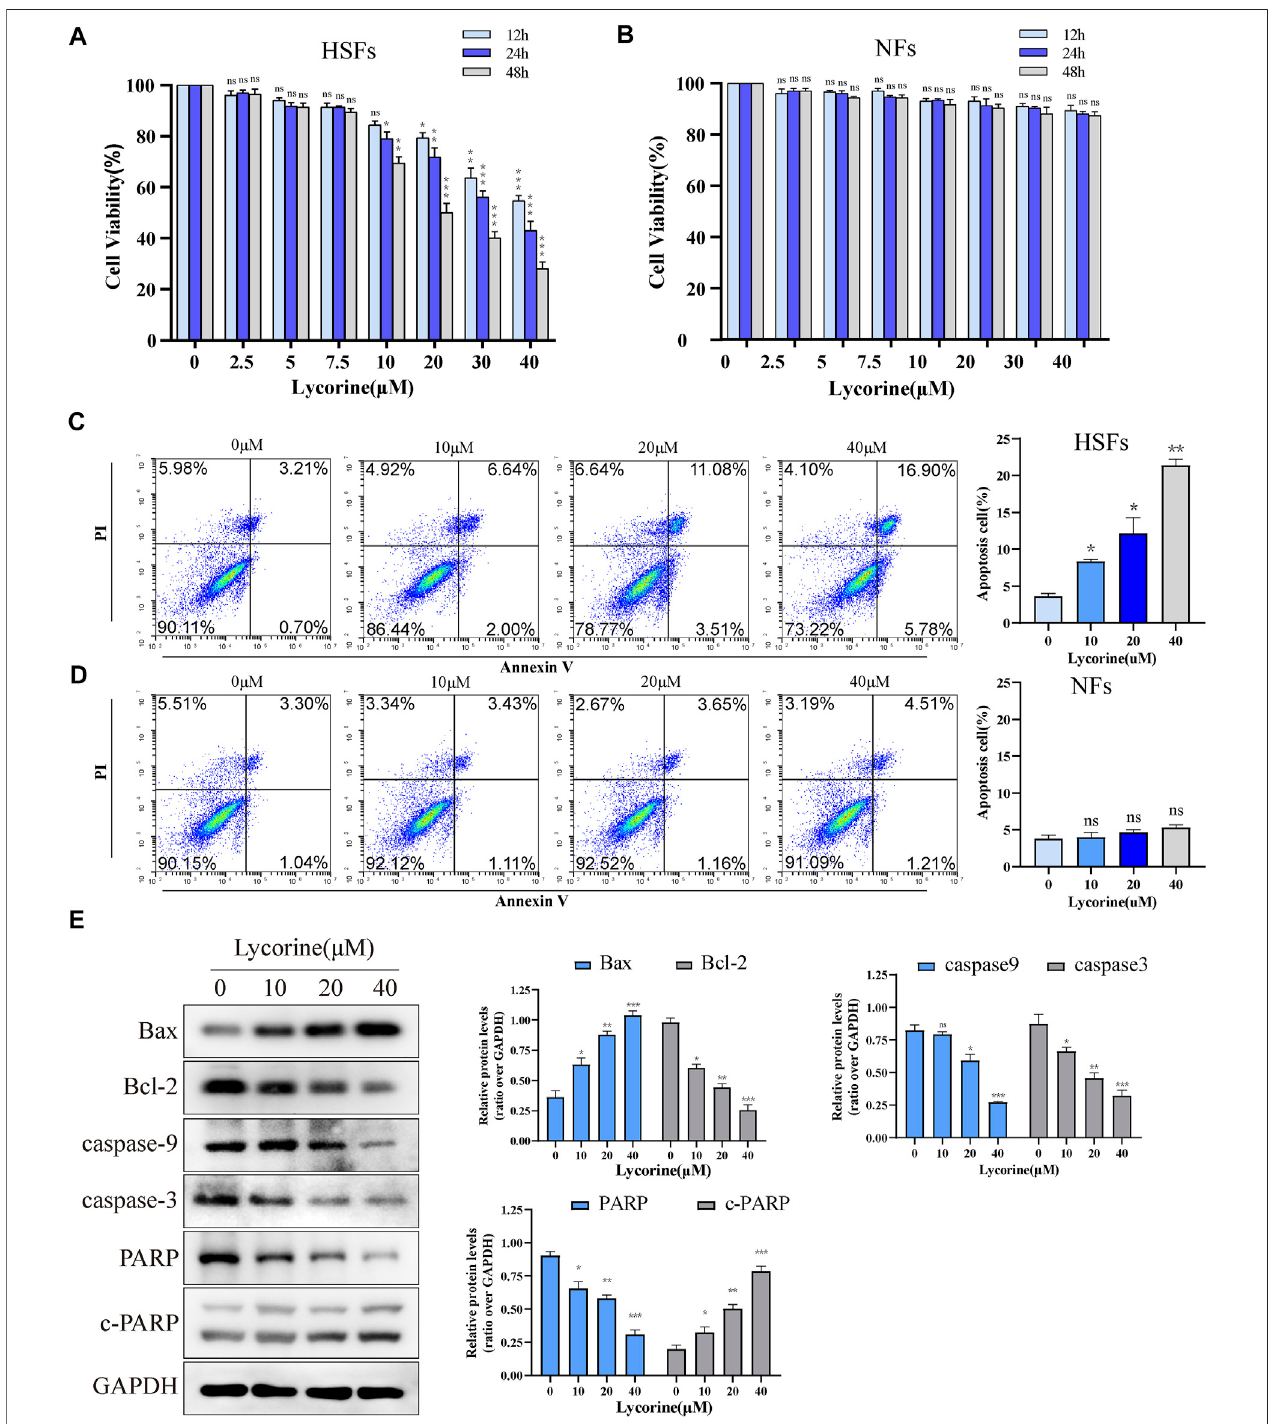
FIGURE 1 | Lycorine reduces the viability of HSFs by triggering their apoptosis. HSFs and NFs were treated with vehicle or lycorine at indicated concentrations. At 12,24and48 hlater,cellviability( n =5)ofHSFs (A) andNFs (B) weredeterminedbyCCK-8assay.Flowcytometricanalysisofthefrequencyofapoptotic HSFs (C) and NFs (D) at 24 h post lycorine treatment ( n = 4). (E) At 24 h post lycorine treatment, the relative levels of Bax, Bcl-2, caspase 9, caspase3, PARP and cleaved PARP (c-PARP) in HSFs were examined by Western blot ( n = 3). Data are mean ± standard error of the mean. * p < 0.05, ** p < 0.01, *** p < 0.001.